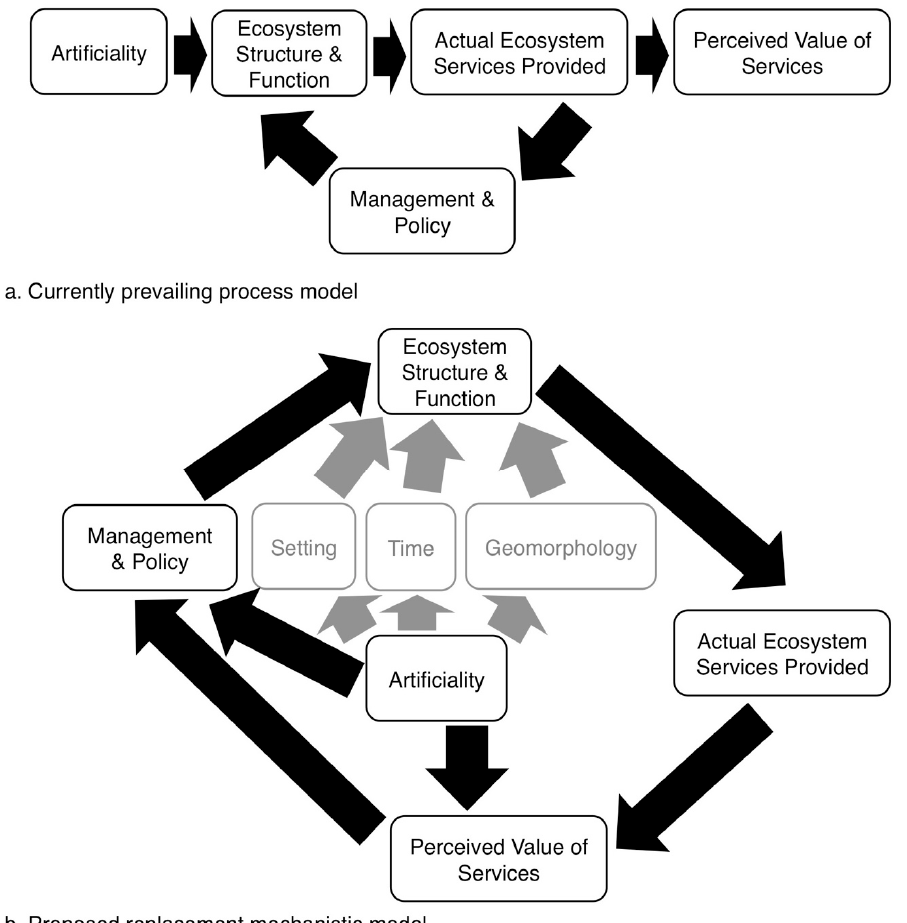
Figure 5. Conceptual diagram of the role of artificiality in the management and services provided by an aquatic ecosystem. ( a ) the currently prevailing process model depicts an approximation of how environmental scientists appear to typically think of the role of artificiality in impacting ecosystems; ( b ) our proposed replacement suggests that, while artificiality may impact ecosystem function directly through mechanisms yet little elucidated, we are more certain that it impacts the perceived value of ecosystem services. Because perception impacts policy, policy affects reality, and reality impacts perception, this proposed replacement process model for the role of artificiality in aquatic ecosystems sets up a positive feedback loop.